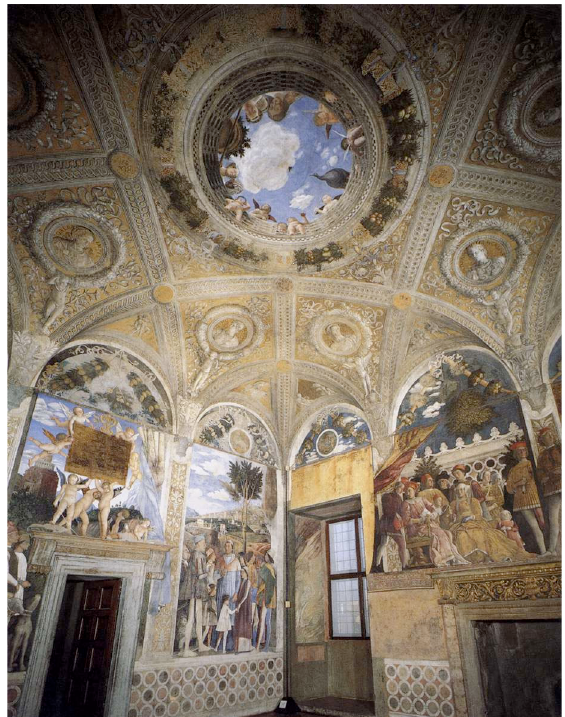
Figure 4. Plan of the surveyed rooms